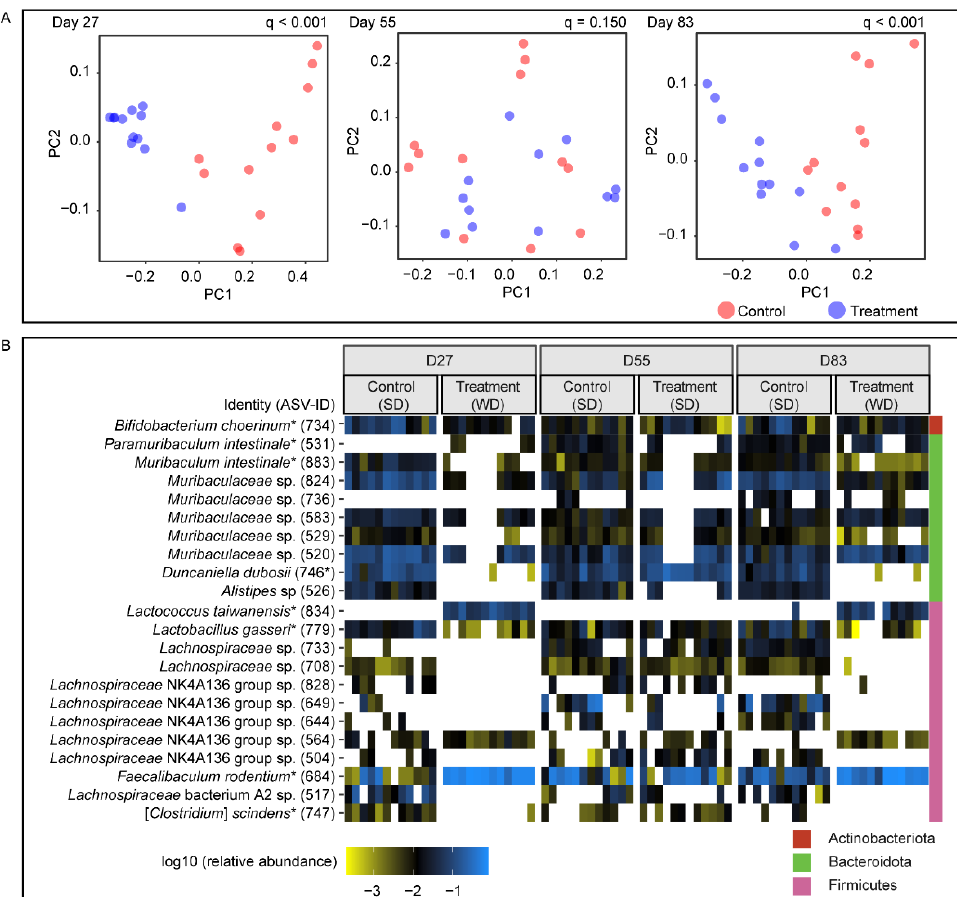
Figure 2. Beta-diversity between fecal microbiota of treatment ( n = 12) and control ( n = 12) groups. ( A ) Principal coordinate analysis (PCoA) plots for day-27, -55, and -83 based on the weighted-UniFrac distance. Statistical significance ( q -values < 0.05) for PERMANOVA tests comparing weighted-UniFrac distance are shown. ( B ) A heatmap of 22 ASVs ≥ 0.5 relative abundance (5,203 counts per sample) per day in treatment and control. The absence of ASV is shown as white. ASVs in bold have >99% 16S rRNA gene similarity to the top BLASTn hit.